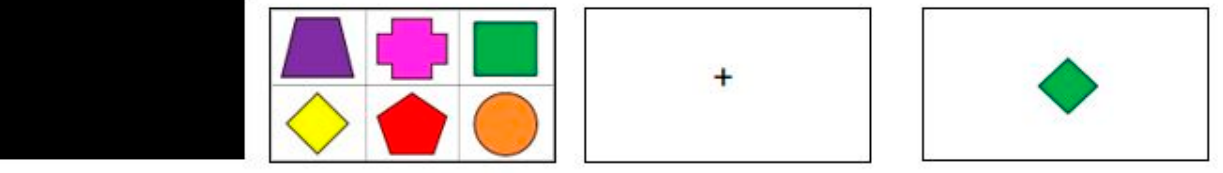
Figure 1. Picture sequence in VBT1.